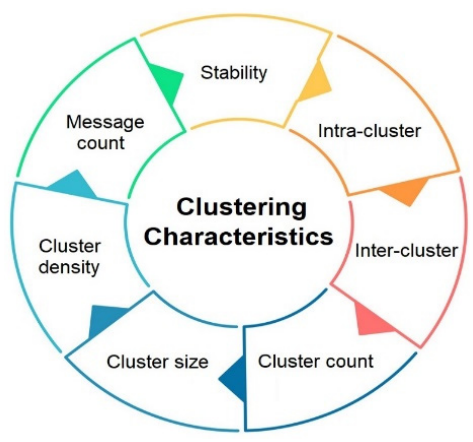
Figure 3. Clustering characteristics in WSNs.